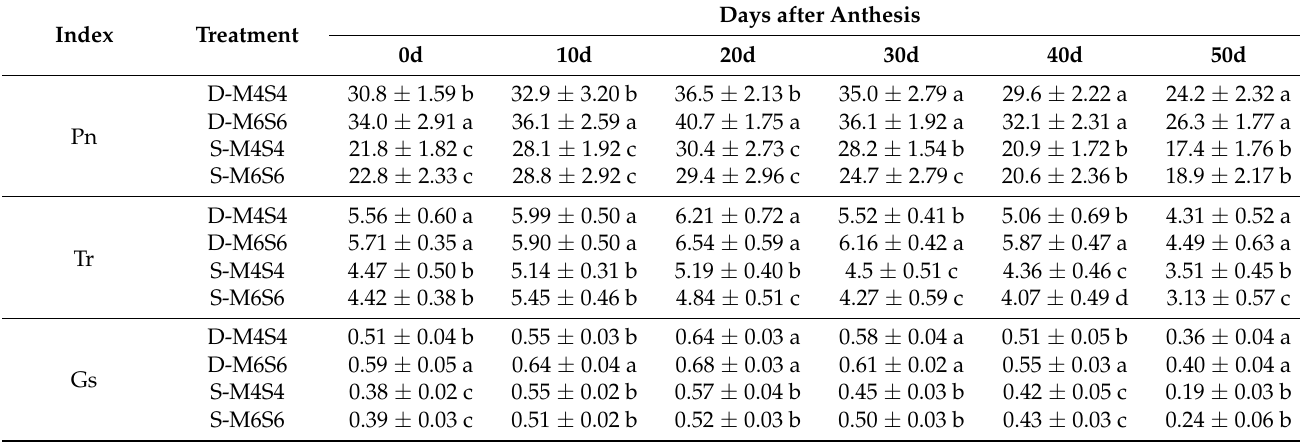
Note: Different lowercase letters in the table indicate significant differences among treatments ( p < 0.05) at the same time: 0 days after flowering is July 25; 10 days after flowering is August 4; 20 days after flowering is August 14; 30 days after flowering is August 24; 40 days after flowering is September 3; and 50 days after flowering is September 13 (the same applies to the following tables). Table 2. Effects of planting pattern and row spacing on chlorophyll fluorescence characteristics of